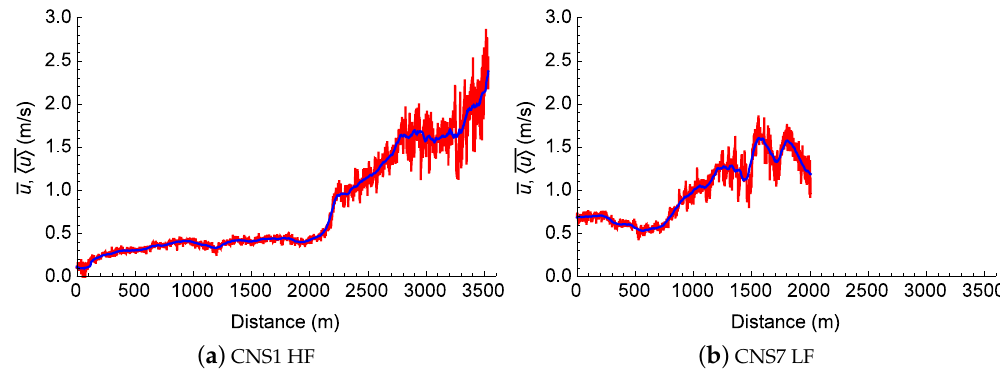
Figure 2. Lateral profiles of depth-averaged velocities u (red) and (cid:104) u (cid:105) (blue).